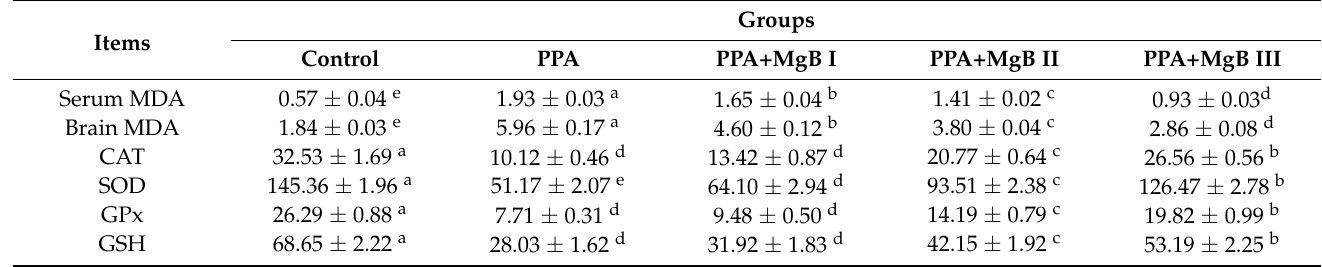
Table 2. Effects of magnesium biotinate (MgB) supplementation on serum and brain malondialdehyde (MDA) levels (nmol/mL or nmol/mg), brain antioxidant enzymes activities (U/mg protein),